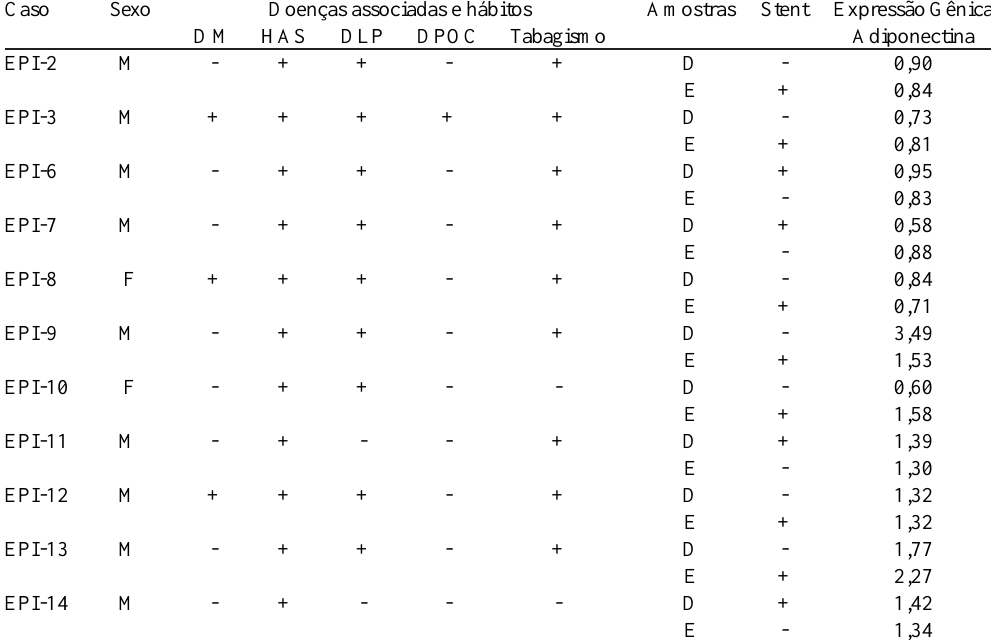
Tabela 1. Correlação entre dados clínicos e resultados experimentais.